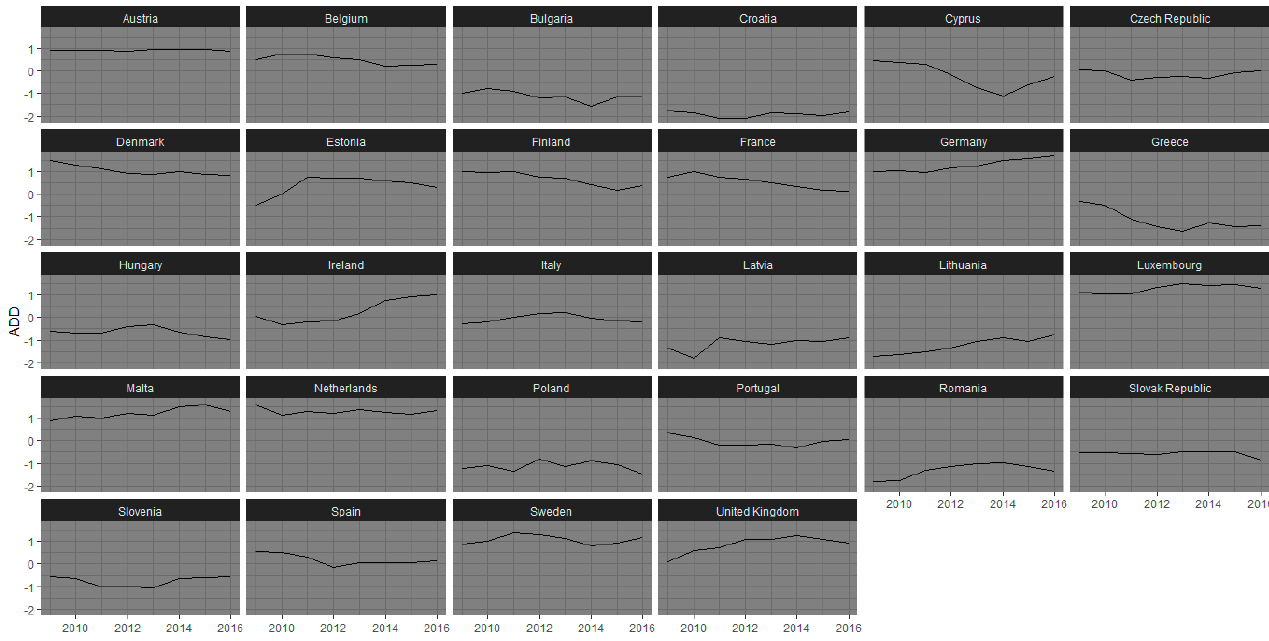
Figure 3. Historical series based on simple additive method (ADD)